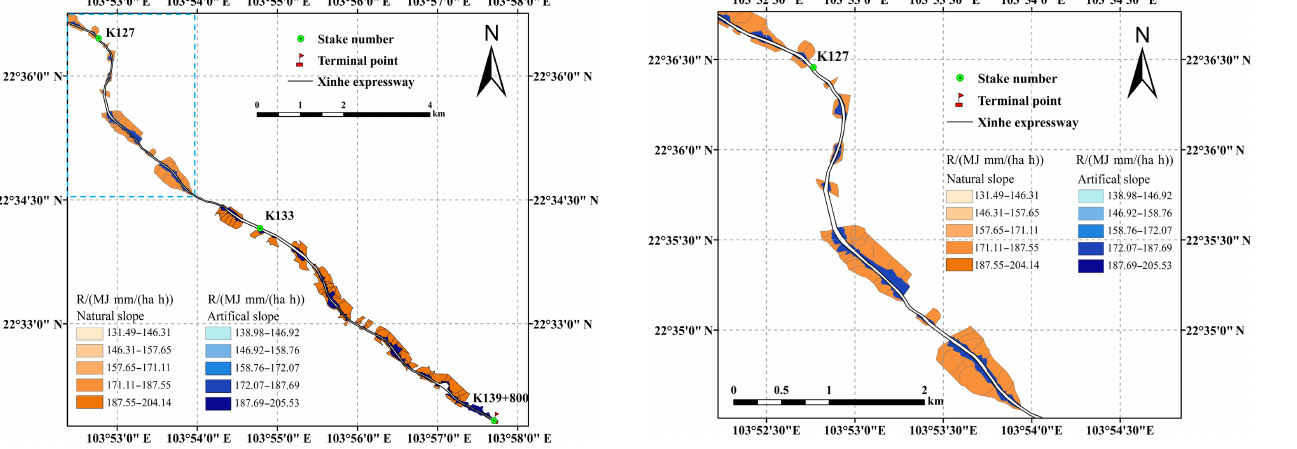
Figure 5. Spatial distribution map of rainfall erosivity factors (K127–K139+800).